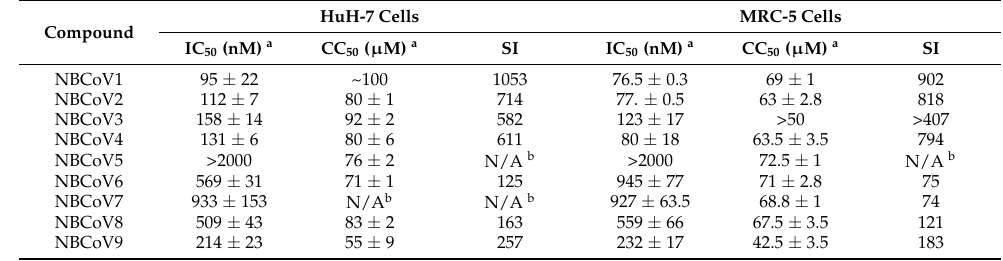
Table 3. Antiviral activity of the NBCoV small molecules in a single-cycle assay in different cell lines against pseudovirus NL4-3 ∆ Env-NanoLuc/MERS-CoV (IC 50 ), toxicity (CC 50 ), and selectivity index (SI).